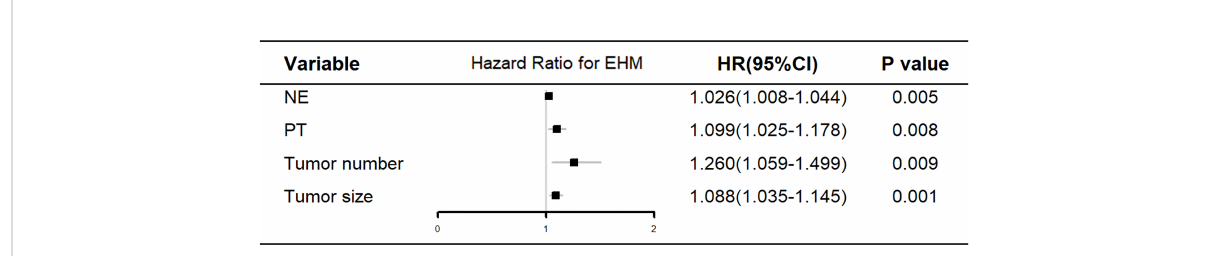
FIGURE 2 Multivariate analysis of the clinical characteristics for predicting EHM in the training cohort. NE, neutrophil; PT, prothrombin